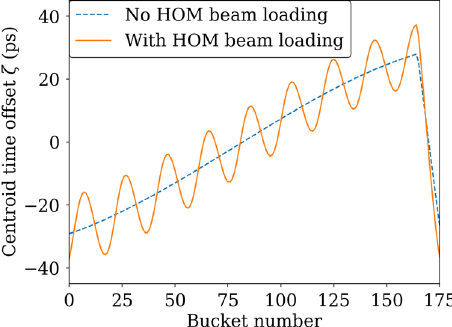
FIG. 1. Bunch-centroid time offsets with beam loading of the HOM at the threshold shunt impedance of the quadrupole instability compared to the case with no HOM beam loading at all. The results are for a case where 165 out of 176 rf buckets are filled and the Landau cavities are detuned by þ 150